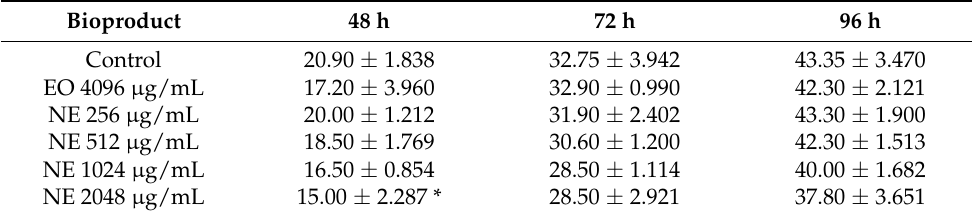
Table 3. Diameter (mm) of A. flavus colonies in the presence of EO and NE at 48, 72, and 96 h. Bioproduct